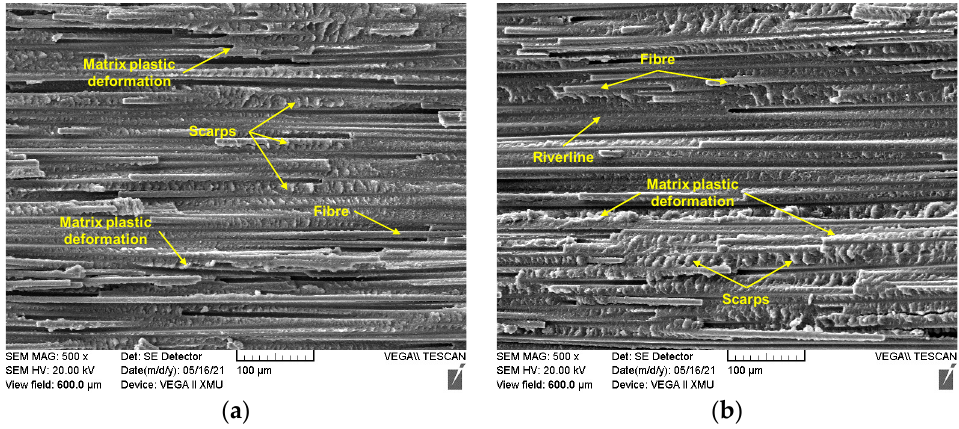
Figure 12. Fracture surface morphology of different off-axis tension specimens: ( a ) 45°; ( b ) 60°.